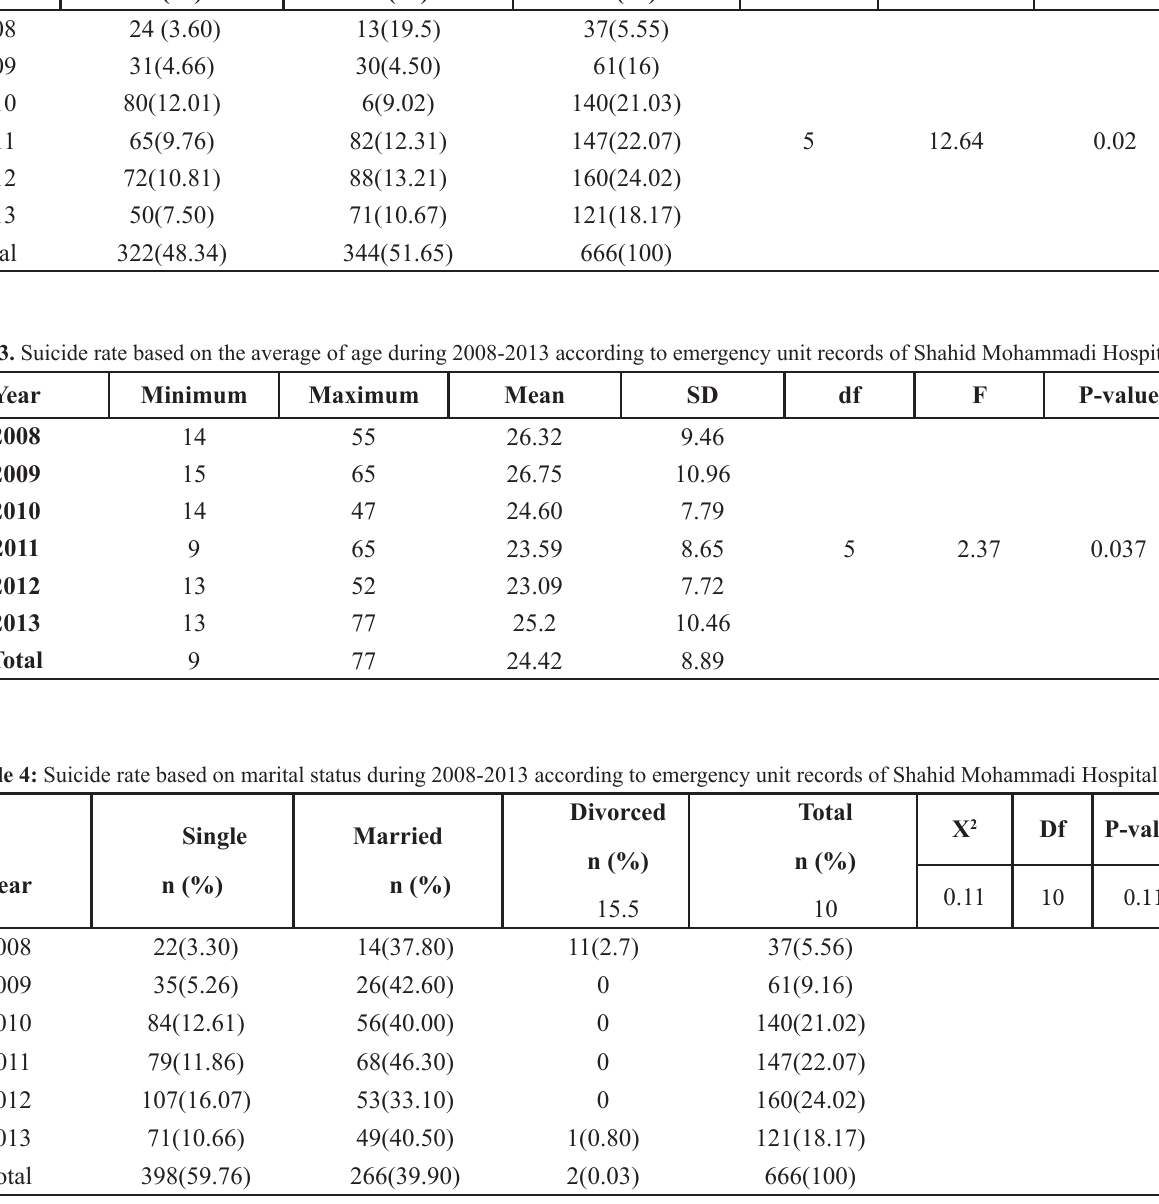
Table 2. Suicide rate based on gender during the 2008-2013 period according to emergency unit records of Shahid Mohammadi Hospital Year